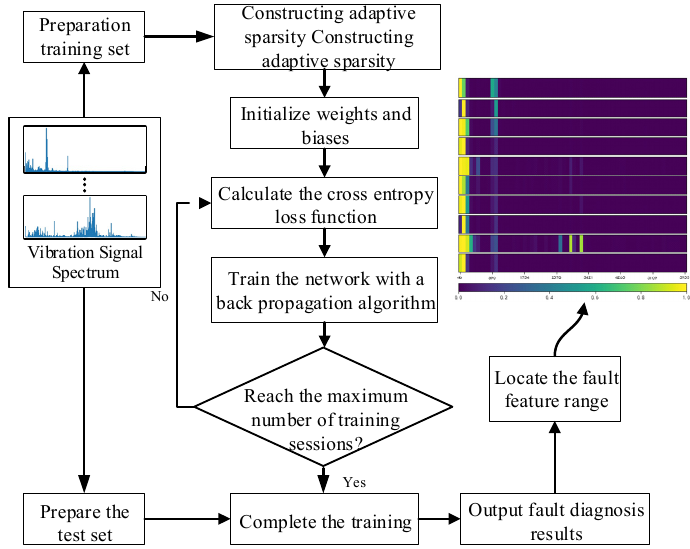
Figure 4. Flowchart of fault diagnosis method.